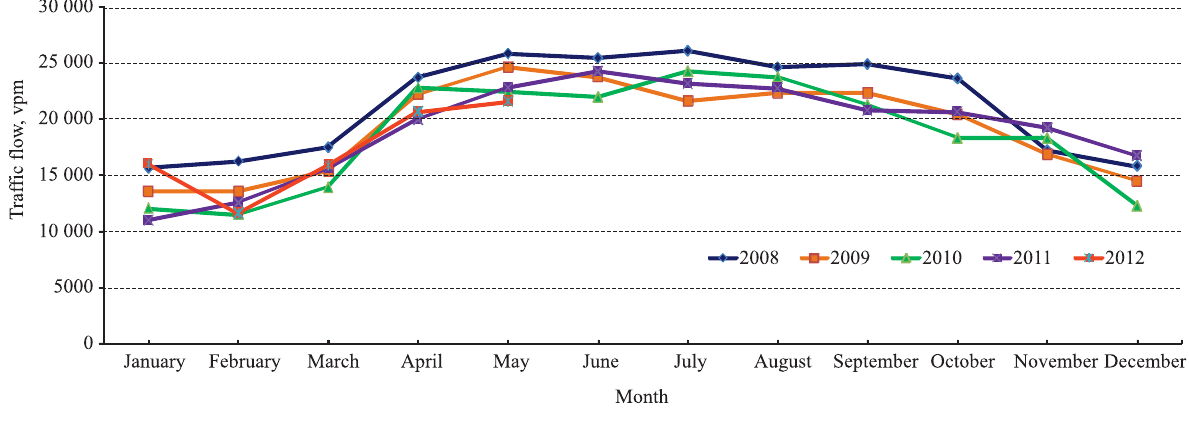
Fig. 2. Traffic flow distribution in the loaded traffic lane in 2008–2012